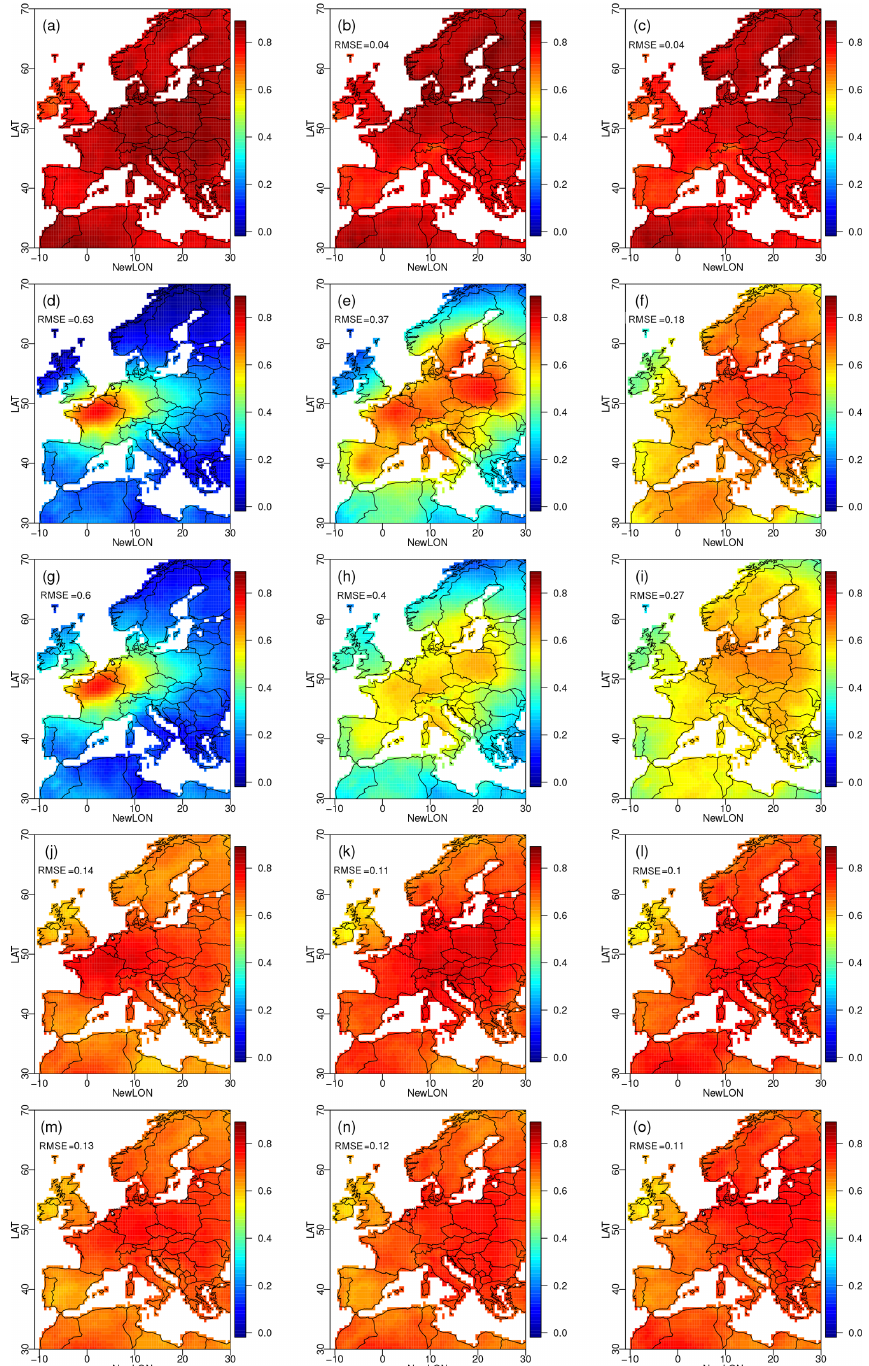
Figure 1. Maps of temperature autocorrelations of the order of 1d for winter over the 1979–2016 period, for (a) WFDEI, (b) IPSL raw simulations, (c) 1d-BC (CDF-t), (d) R.1.1.0, (e) R.5.1.0, (f) R.100.1.0, (g) R.1.2.0, (h) R.5.2.0, (i) R.100.2.0, (j) R.1.1.1, (k) R.5.1.1, (l) R.100.1.1, (m) R.1.2.1, (n) R.5.2.1 and (o) R.100.2.1. In other words, the second row shows the results for temperature as a conditioning dimension (for different numbers of locations) and without accounting for lags; the third row is the same but for temperature and precipitation together as a conditioning dimension; the fourth and fifth rows are the same as the second and third rows but with lags accounted for. For panels (b–o) , the RMSE value, computed over the whole domain between WFDEI autocorrelations and those from the model or corrected data, is